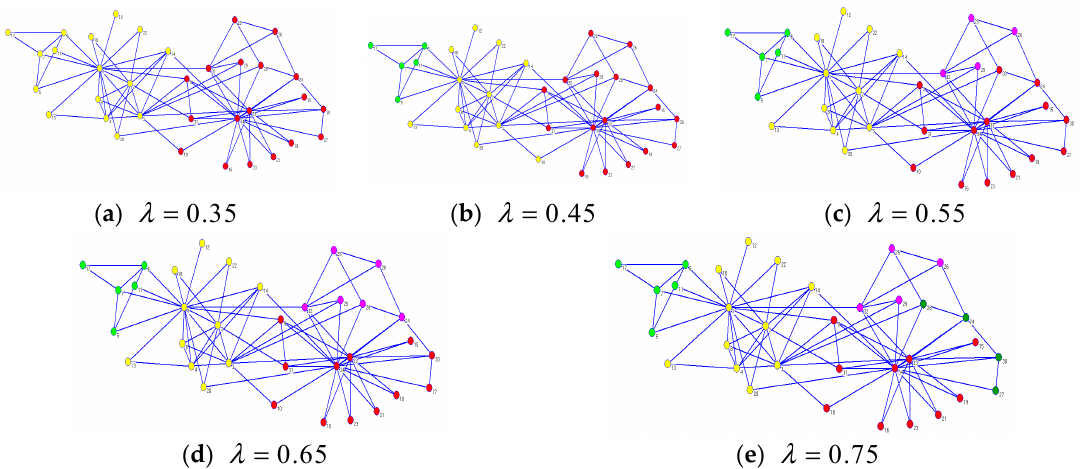
Figure 5. (Color online) Detected communities on Zachary’s karate club network for different values of λ .